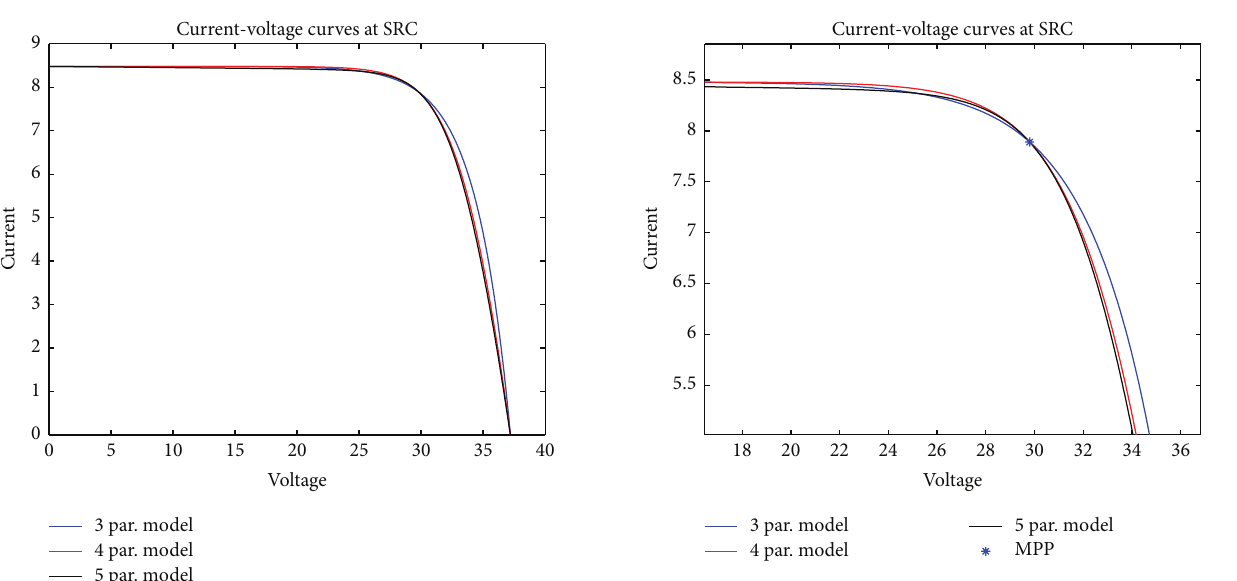
Figure 7: Close-up around maximum power point of Current- Voltage curves at SRC of BP 3 235T, traced by using 3/4/5 parameter models.